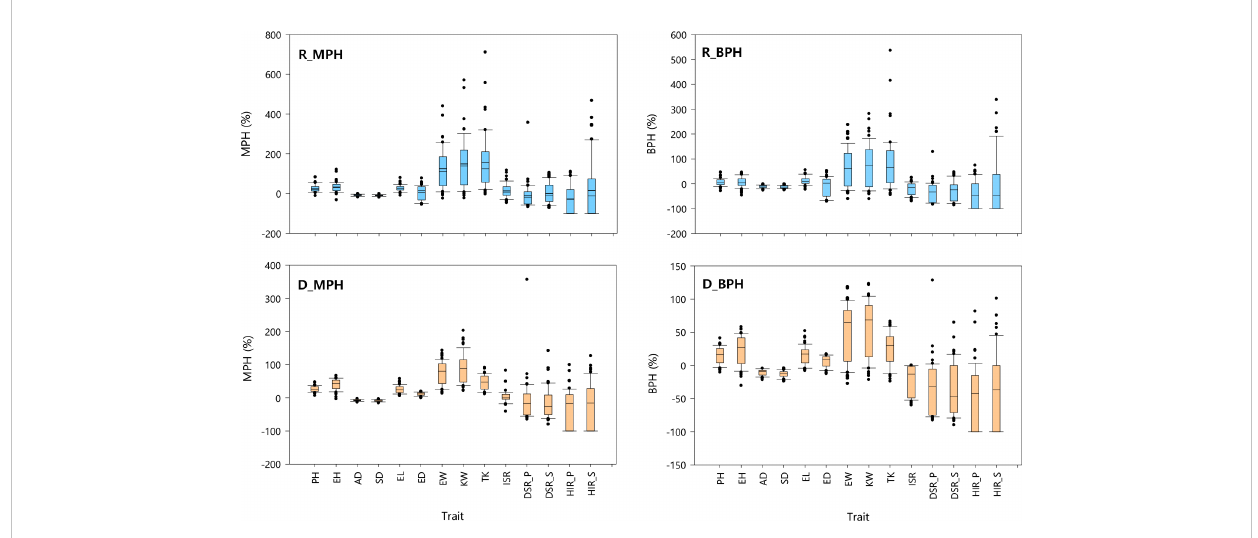
FIGURE 1 Heterosis performance of 56 crosses in the rainy (R_MPH and R_BPH) and dry (D_MPH and D_BPH) seasons. MPH, mid-parent heterosis; BPH, best- parent heterosis; PH, plant height; EH, ear height; AD, anthesis date; SD, silking date; EL, ear length; ED, ear diameter; EW, ear weight; KW, total kernel weight per ear; TK, total kernel number per ear; ISR, the R1-nj seed set of inducers; DSR_P, the R1-nj seed set with donor P789; DSR_S, the R1-nj seed set with donor S7328; HIR_P, haploid induction rate with donor P789; HIR_S, haploid induction rate with donor